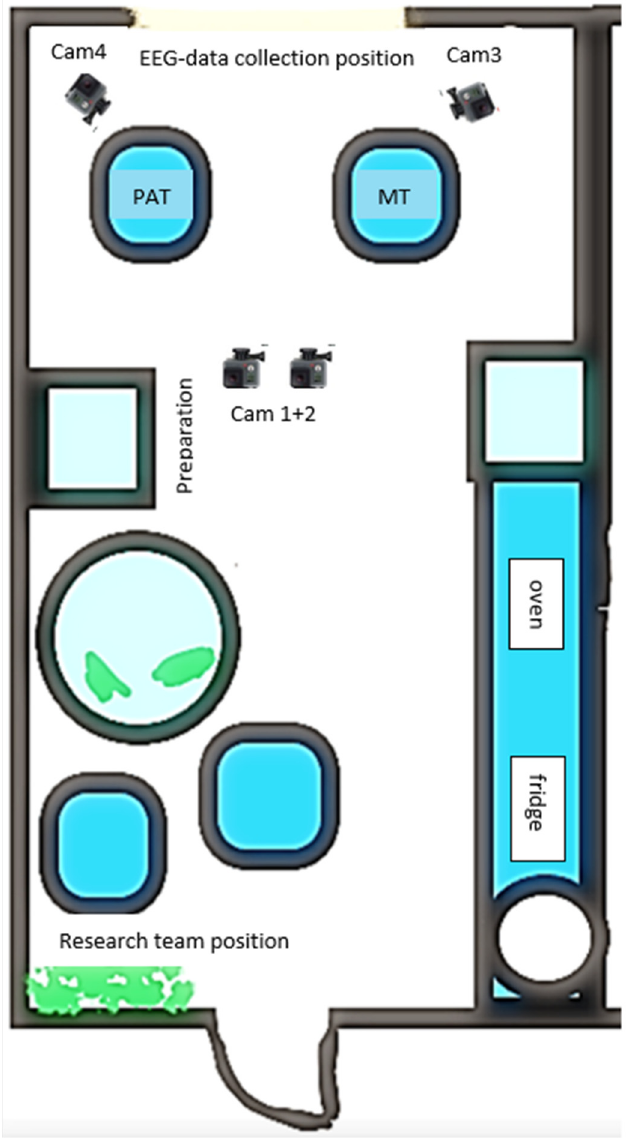
Figure 2. Room layout of the mobile lab in the rehabilitation clinic.